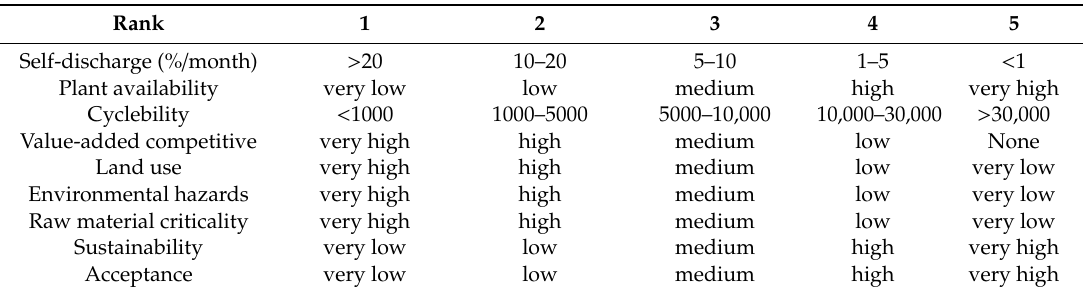
Table A8. Qualitative assessment of selected parameters used as input for the AHP and utilized in Tables A4 and A6.